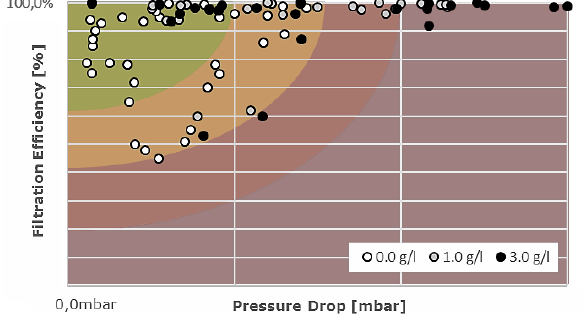
Fig. 10. Trade-off between filter efficiency and exhaust back pressure with different soot loadings While in the past, high filtration efficiencies were al- most inevitably associated with high backpressure (red and yellow areas in Fig. 10), current developments are already leading to much more favorable relations – green area in Fig. 10 – although partially with compromises on filter size.